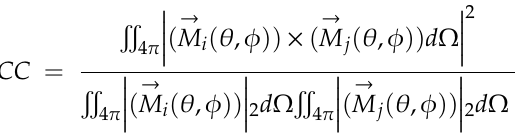
Figure 14. The radiation efficiency of the proposed MIMO antenna array.